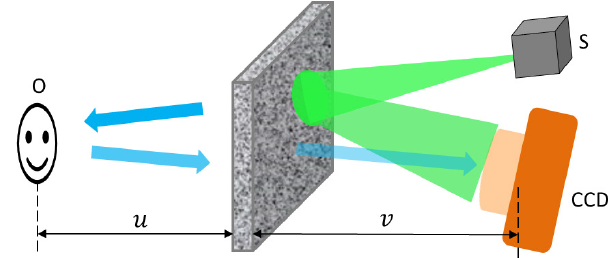
Fig. 3. A schematic of experiment setup. u ¼ 10 cm and v ¼ 3 : 5 cm are distances from the object and the CCD camera to the medium, respectively. The cerulean lines denote the light Fig. 2. A comparison of an average path length di®erence (cid:1) s transmitted through the scattering medium. Its wavelength is (cid:2) N versus location x . and an average number of scattering the same as the green ones.